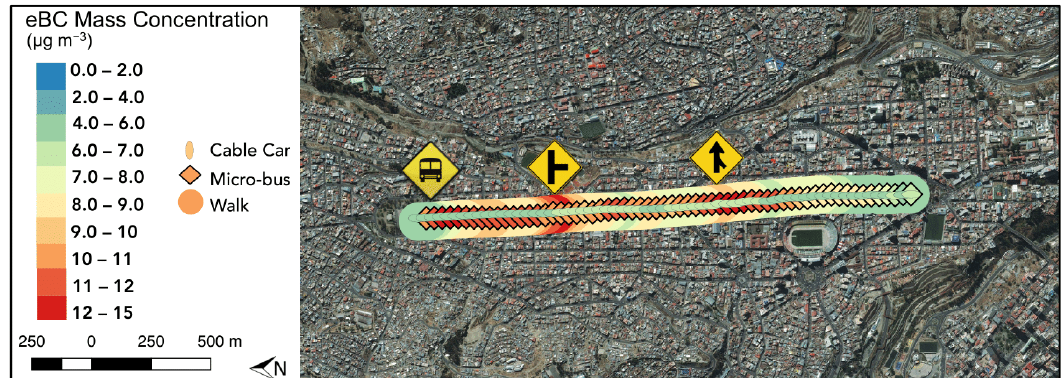
Figure 5. Median eBC mass concentration in TMEs during all morning peak traffic measurements in Street 1. Shapes correspond to walking (circle), microbus (diamond), and cable car (oblong). Symbols signify a bus stop, major intersection, and merging road (left to right).